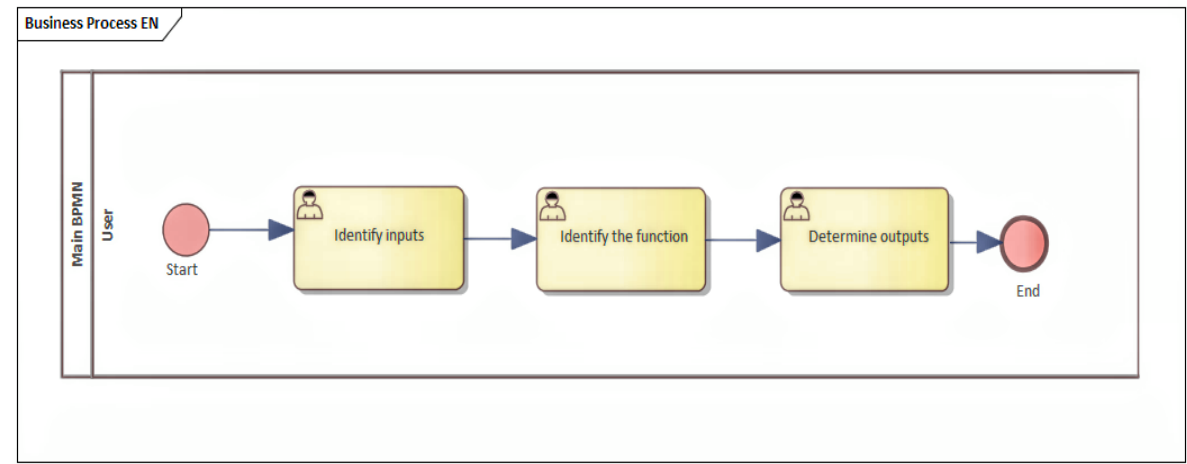
Figure 7. Identification of inputs, outputs, and functions of the device.